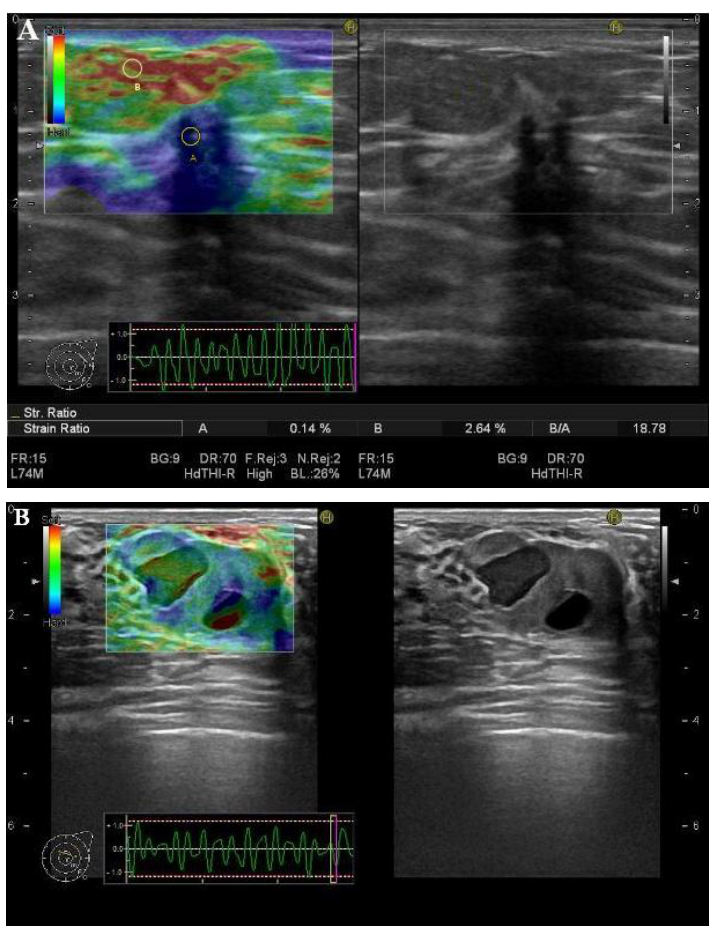
Figure 1. Co-registered Strain elastography (SE) (left) and ultrasound B-mode (right) images of ( A ) a hard (blue) malignant breast tumor (ductal carcinoma) and ( B ) a soft (green) benign breast neoplasm (fibroadenoma). The regions of interest (ROIs) placed in the tumor (A) and in the adjacent soft tissues (B) are used to calculate a strain-ratio (SR) (B/A) (right lower corner). The benign neoplasm (B) contains two hypoechoic areas, one of which yields a classic elastogram for a cyst with three color layers (blue-green-red) from top to